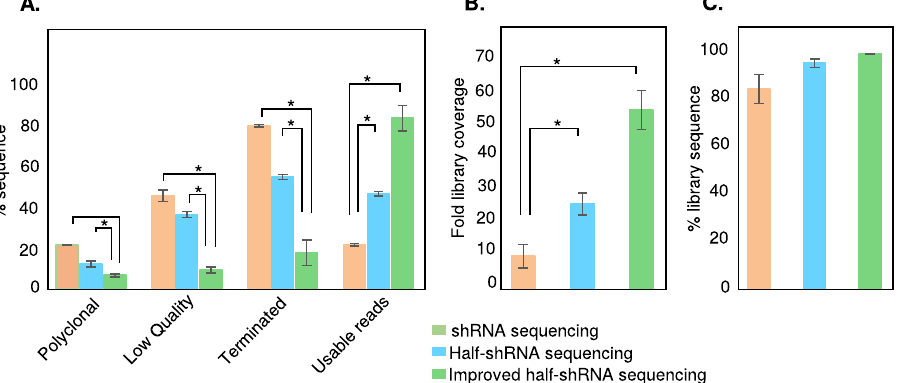
Figure 6. Comparison of the quality of sequencing across different methods. ( A ) Comparison of metrics from shRNA, half-shRNA and improved half-shRNA library sequencing. Polyclonal reads are presented as percentage of initial loading and enrichment. Low quality reads are presented as percentage of total sequence output after loading, enrichment and initial polyclonal removal. Terminated and barcoded library reads are presented as percentage of total filtered reads by Ion Torrent server. ( B ) Comparison of library fold coverage from shRNA, half-shRNA and improved half-shRNA library sequencing. ( C ) Comparison of identified library sequences from shRNA, half-shRNA and improved half-shRNA library sequencing. * p <